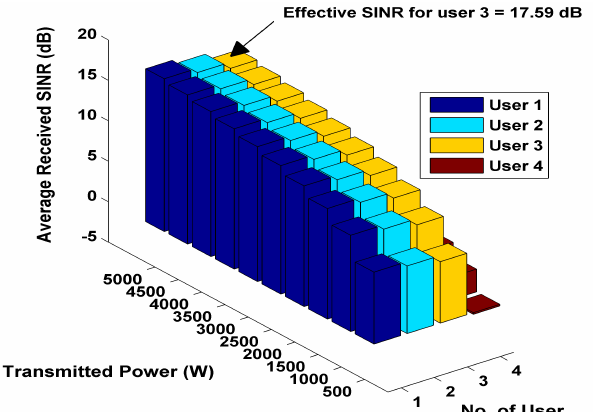
Figure 11. Estimated average received SINR versus transmitted power in presence of CoMP − JT − based mmWave signal